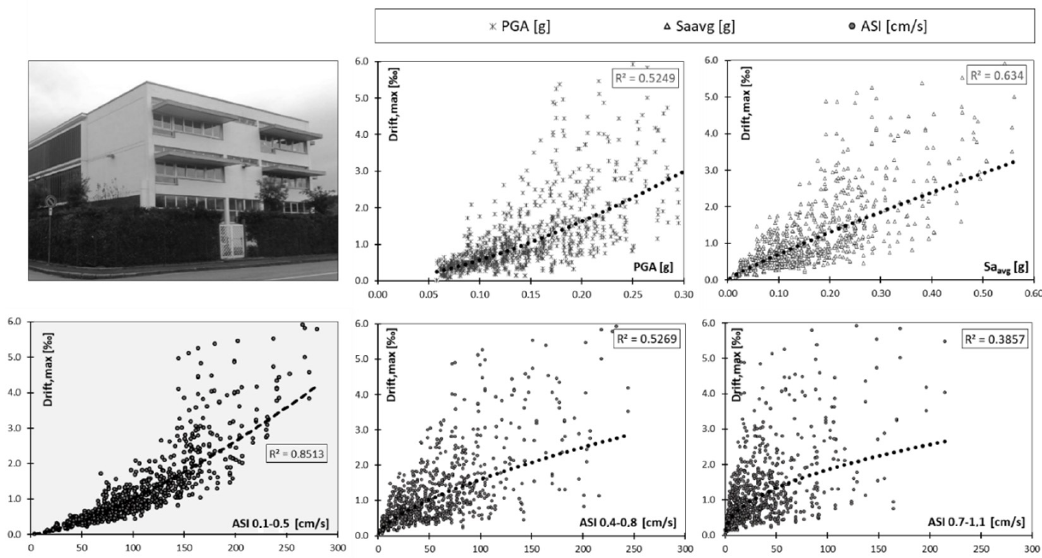
Figure 13. Results of the SMAV analysis of CS1.